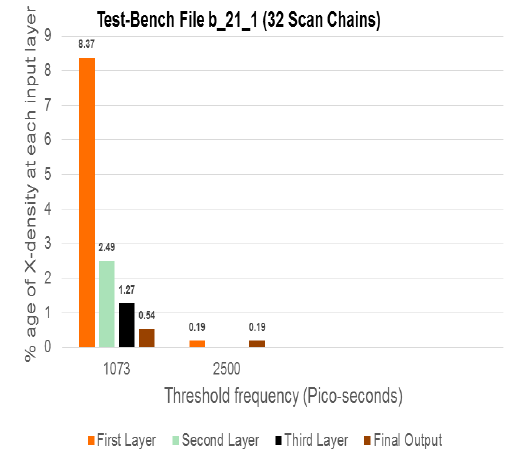
FIG. 10: TEST BENCH FILE B21_1 (32 SCAN